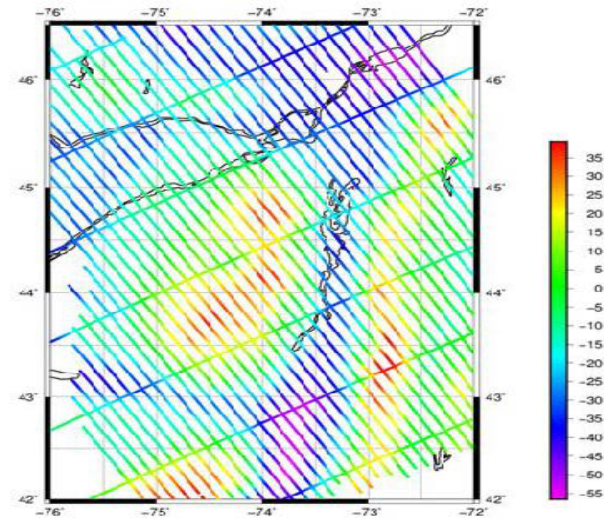
Figure 14: Observed free-air gravity anomalies in the New Hamp- shire test area from − 55 to 35